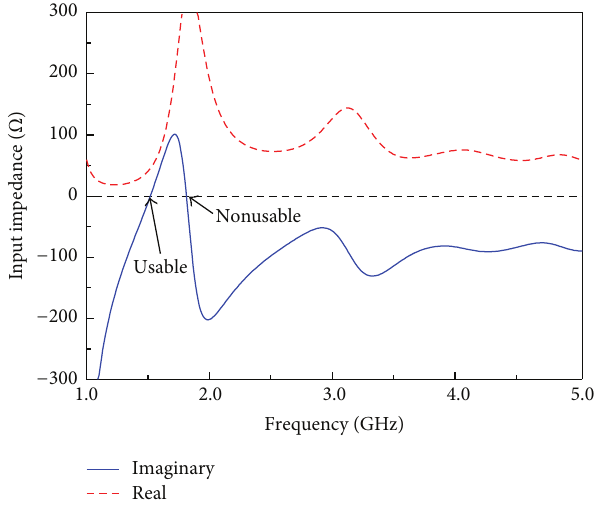
Figure 3: Simulated input impedance ( 𝑍 11 or 𝑍 22 ) of the ideal symmetrical four-arm curl antenna ( 𝑛 1 = 𝑛 2 = 𝑛 3 = 𝑛 4 = 1 ).